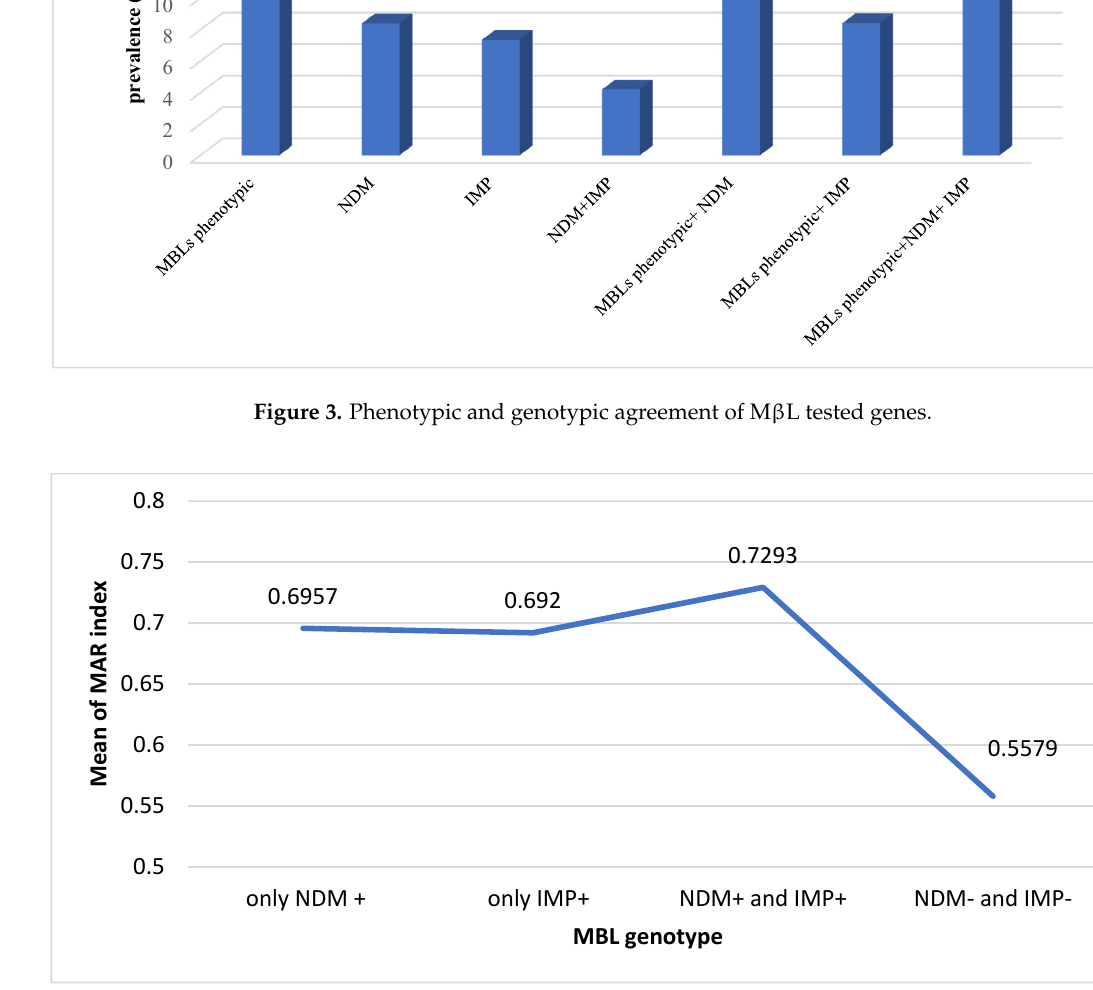
Figure 4. Distribution of MAR index mean values ( 𝑥̅ ) among the detected MBLs genotypes. Table 5. Relation between MBLs phenotype, detected genotype and carbapenem resistance across the E. coli